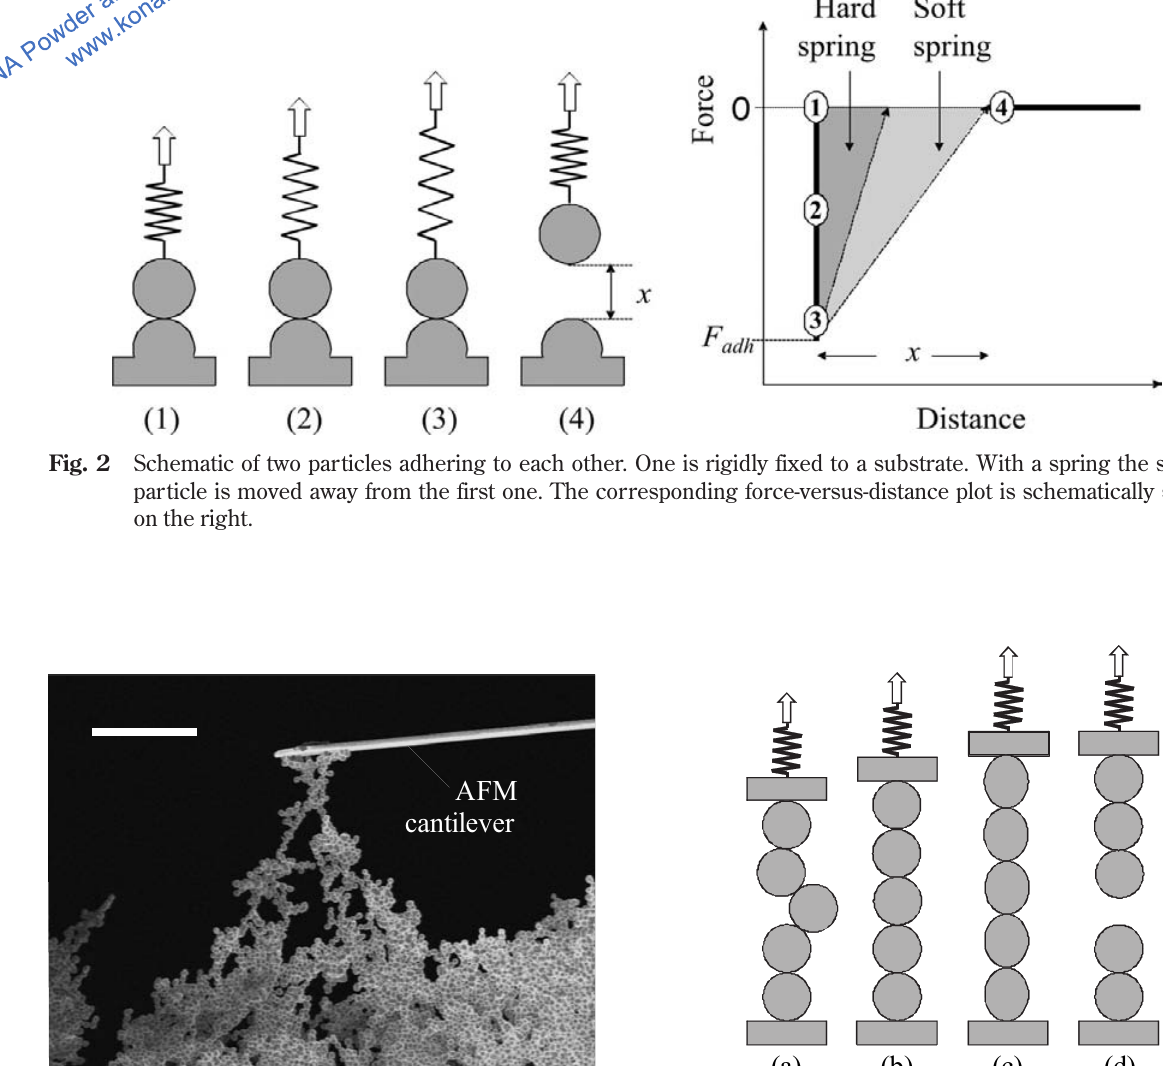
Fig. 3 Scanning electron micrograph of a highly porous powder made of silicon oxide spheres of 1.5 μ m diameter. The cantilever of an atomic force mi- croscope had been moved into the powder and then been retracted. See ref. 92) for details.